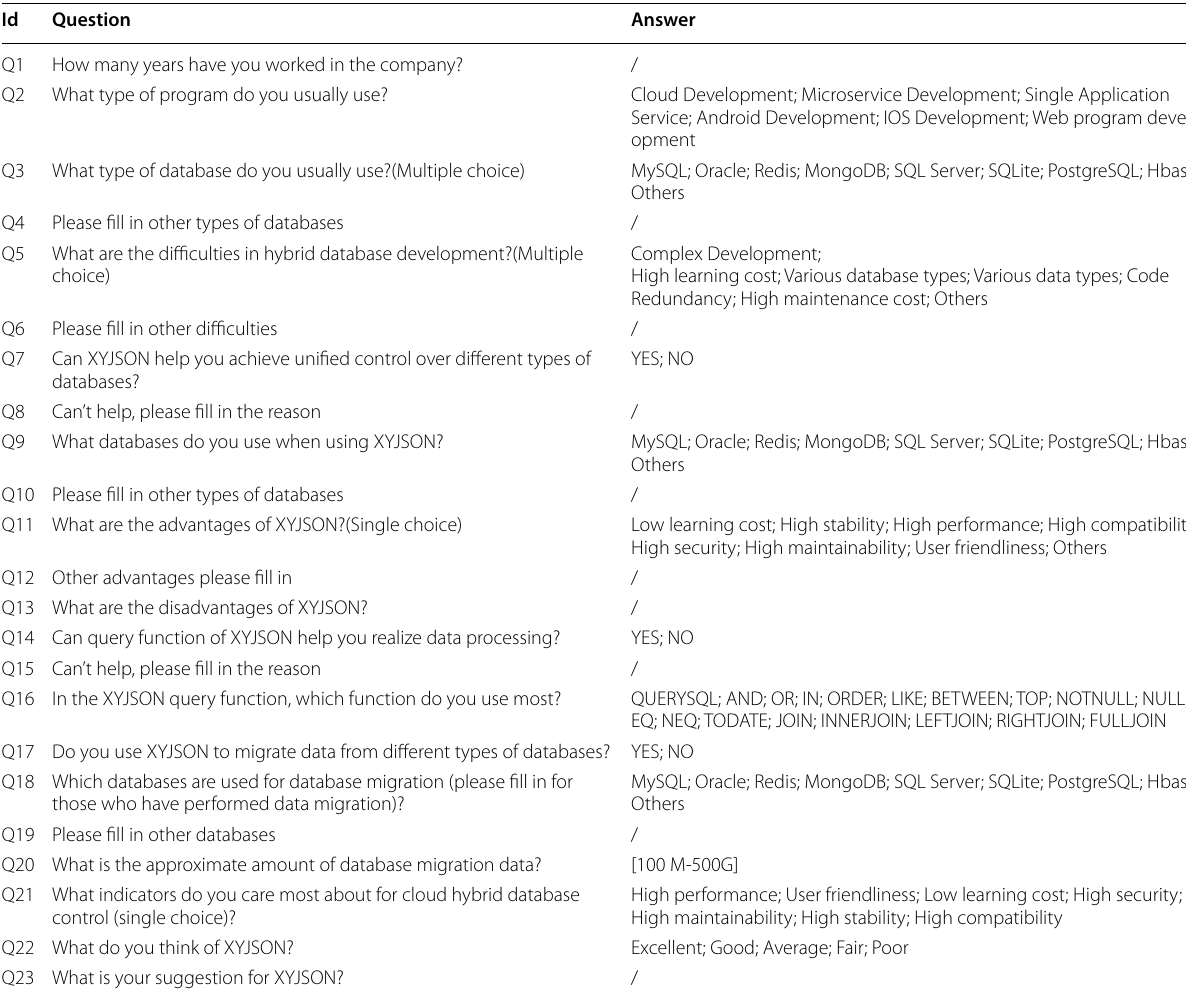
Table 1 Questionnaire